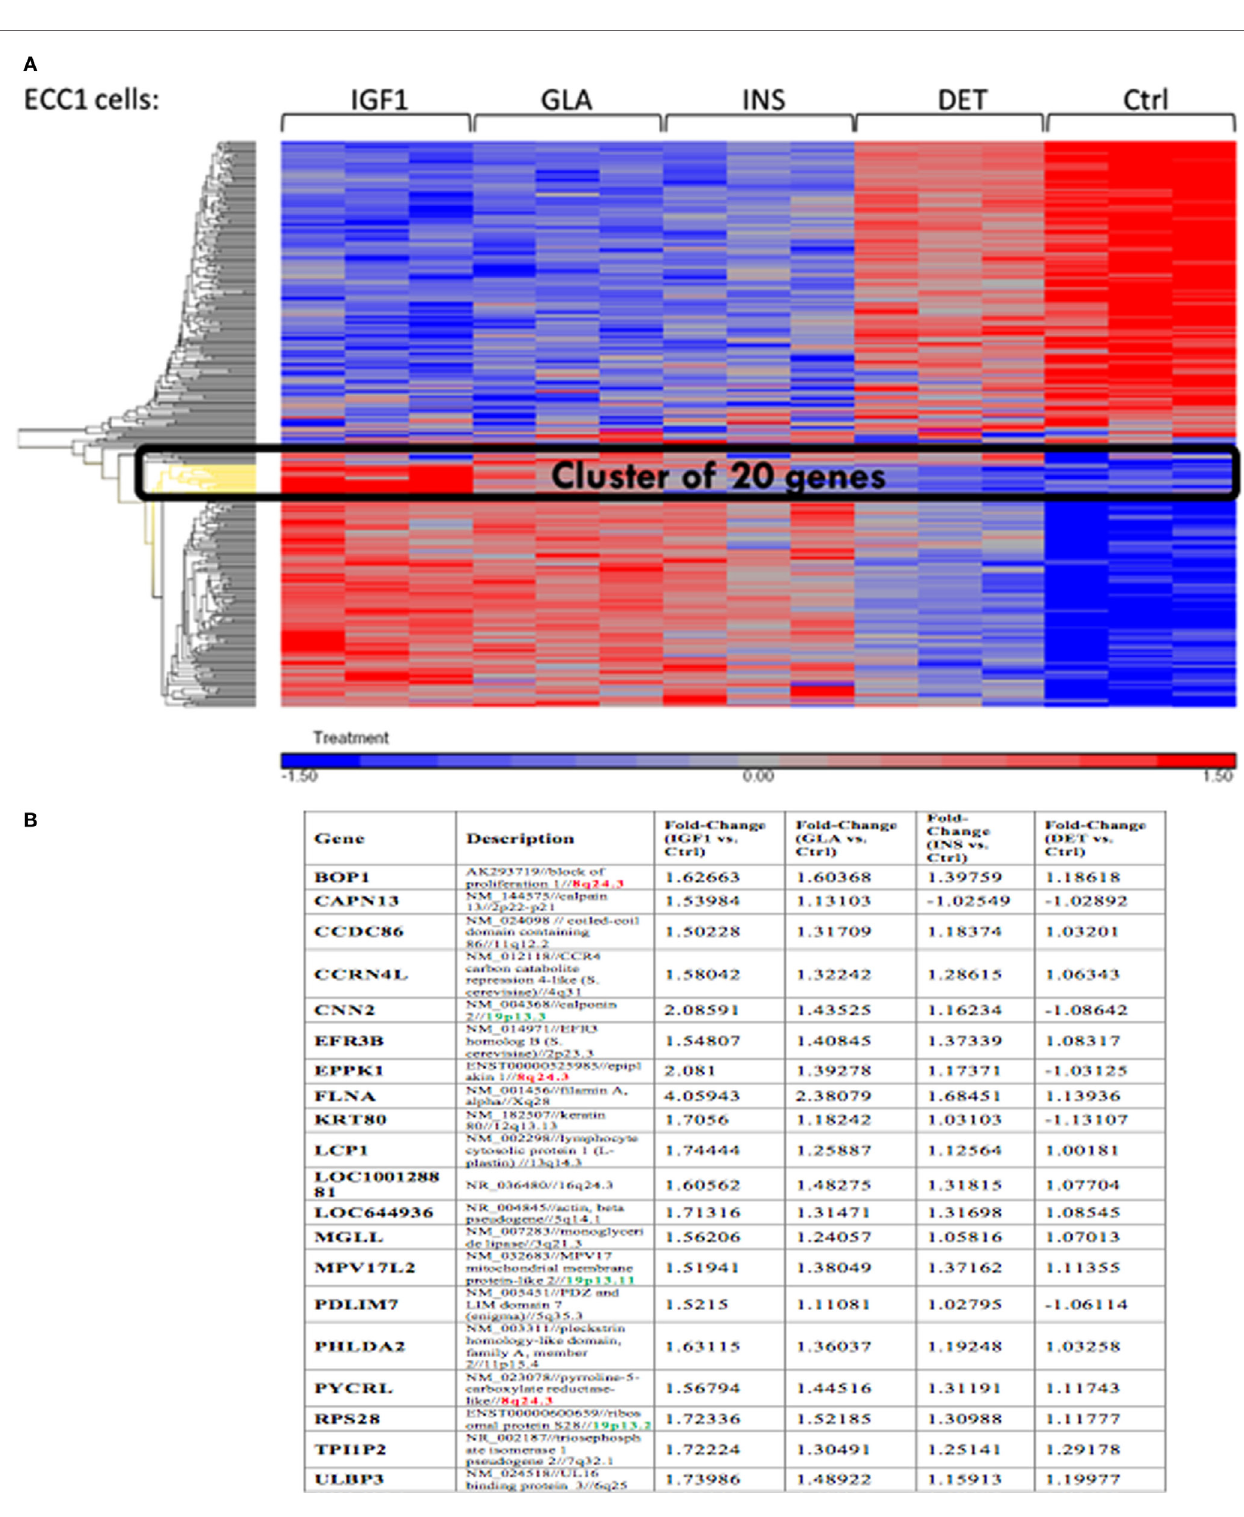
FigUre 4 | Features of differentially expressed genes in ECC-1 cells after ligands treatment. (a) Heatmap of 298 differentially expressed genes that were detected for all four treatments in ECC1 cells; (b) list of the 20 genes from the cluster marked in black in (a) . Fold changes are